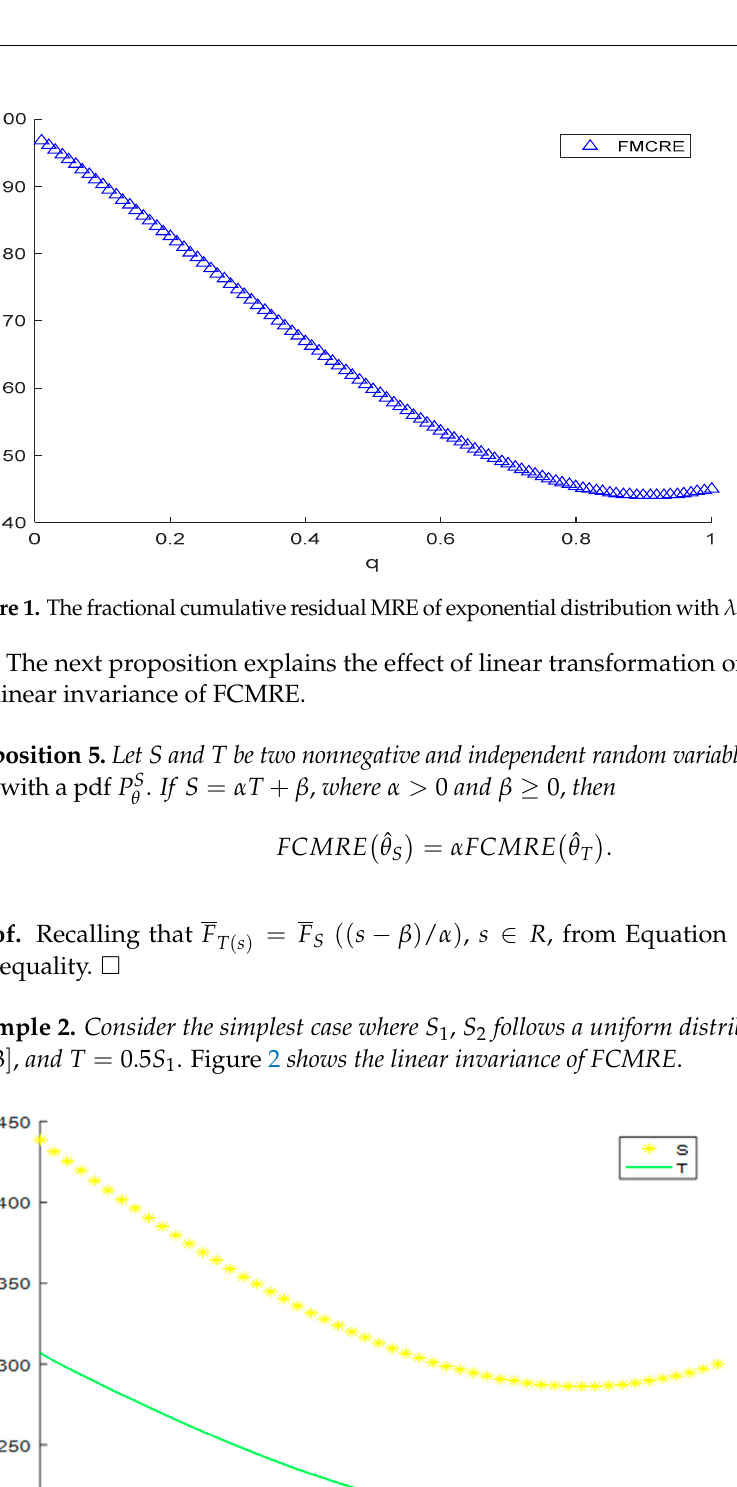
. Figure 2 shows the linear invariance of FCMRE .